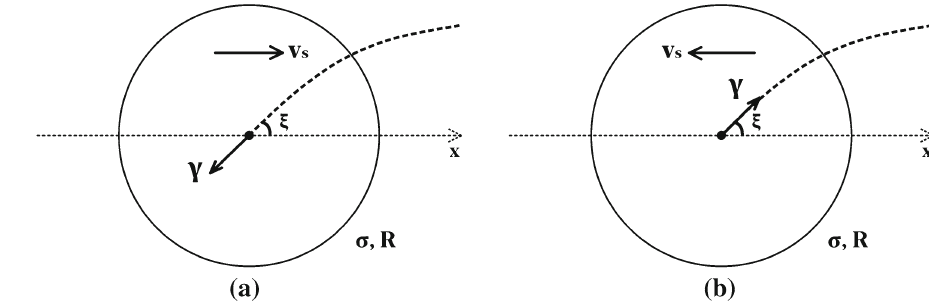
Fig. 5 The original scenario where the particles propagate from infinity to the center of the bubble, shown in a , is equivalent to that in b , where a particle is emitted from the center of the bubble. The photon cannot go